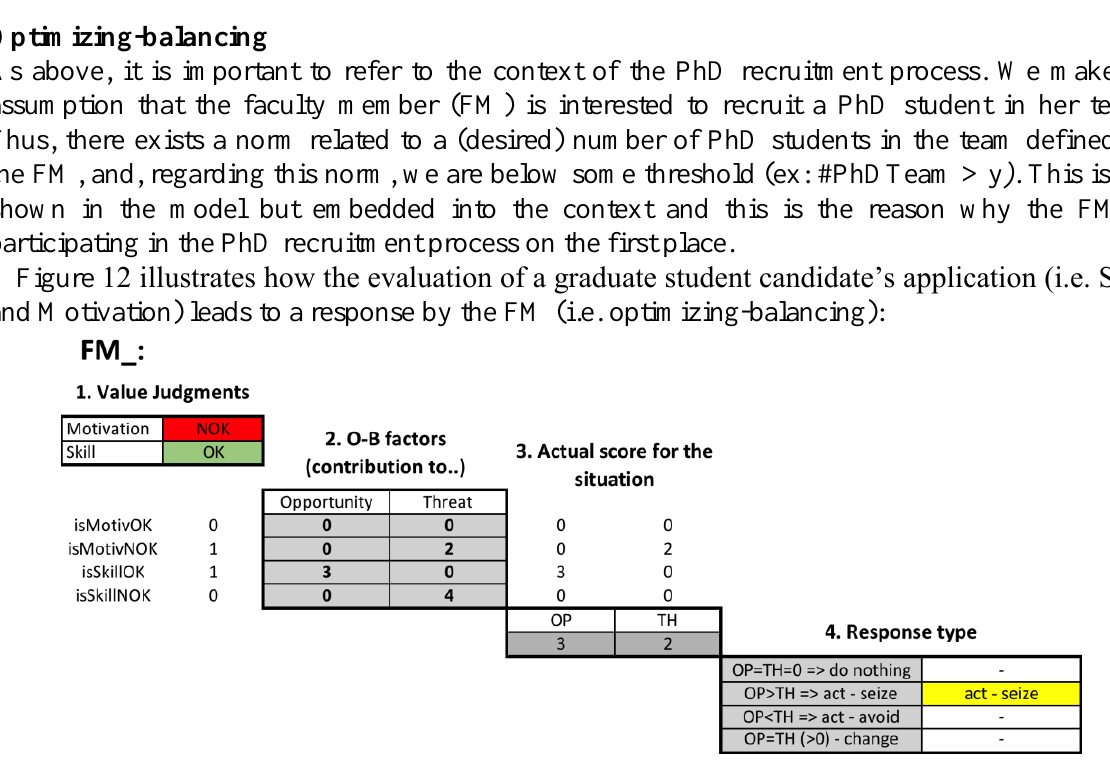
Figure 11. FM – the appreciation statechart for the FM